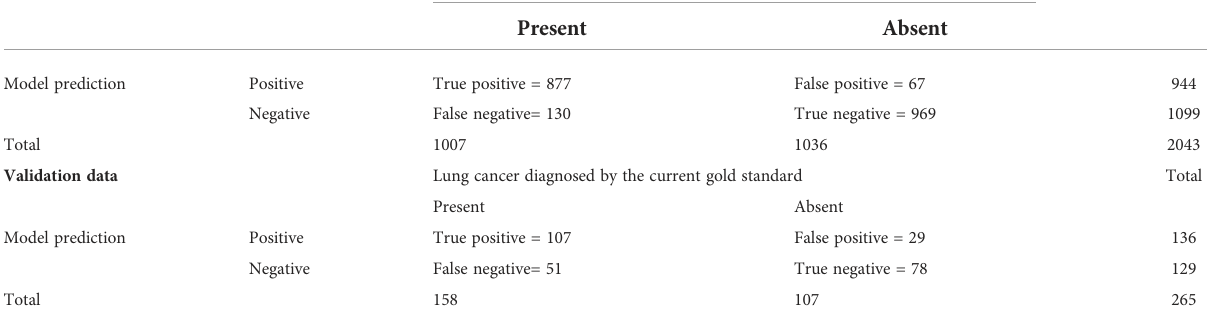
TABLE 2 Confusion matrix of the derivation and validation datasets.